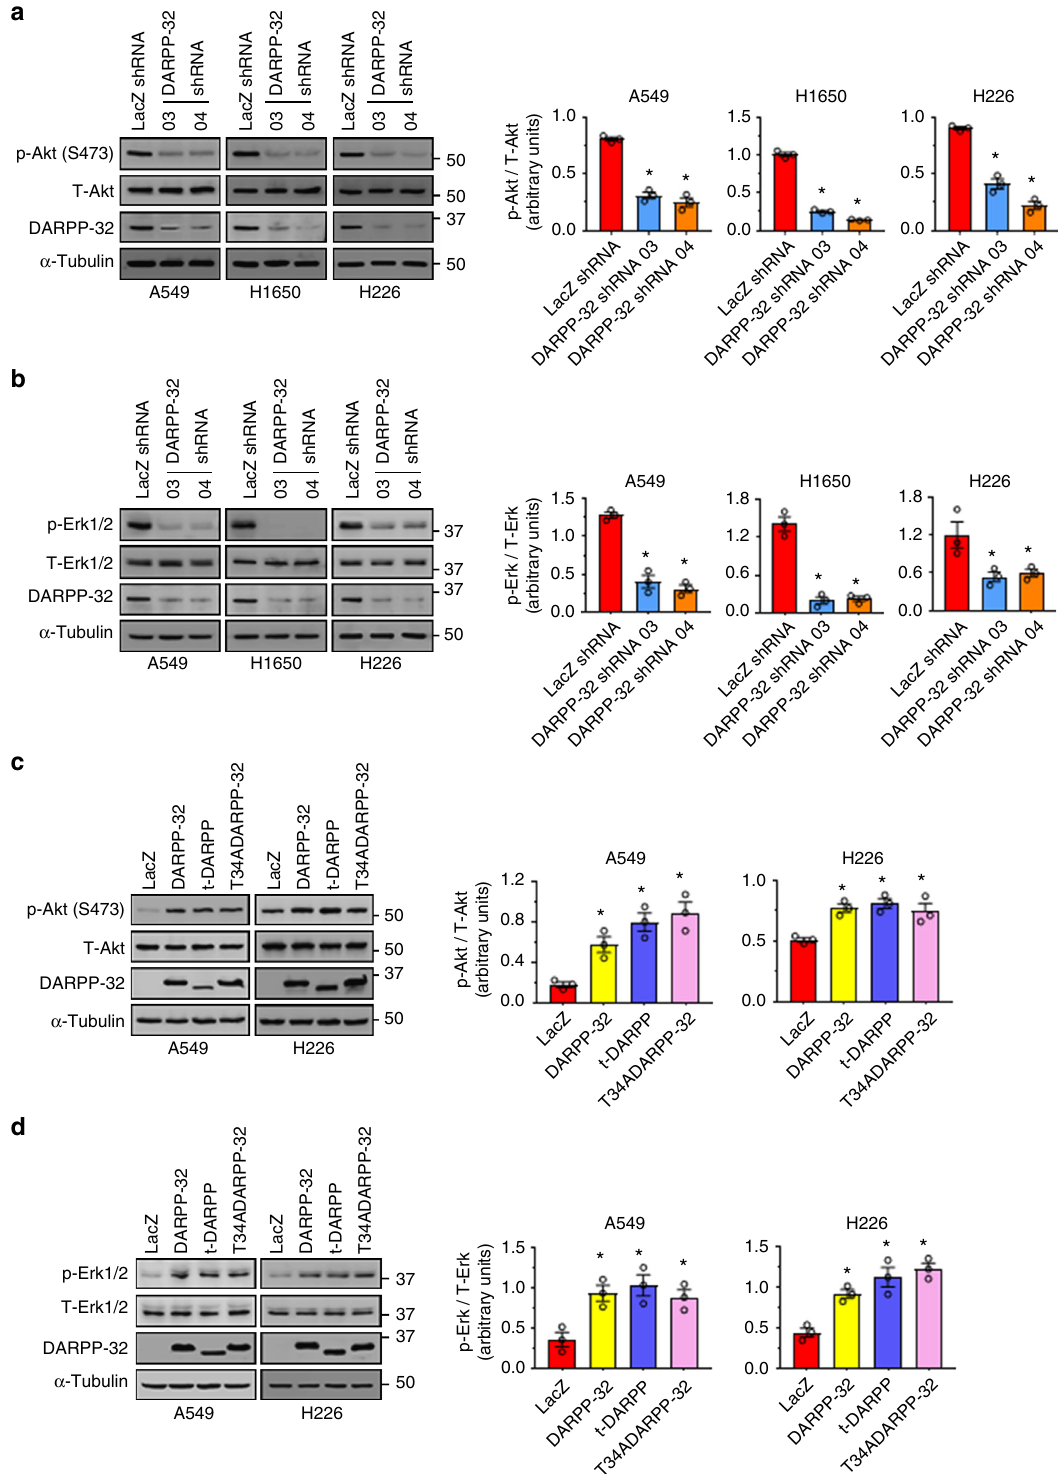
Fig. 2 DARPP-32 regulates cell survival through Akt and Erk1/2. a A549, H1650 and H226 cells were transduced with control or DARPP-32 shRNAs. Cell lysates were collected and immunoblotted with antibodies against phosphorylated Akt (p-Akt; S473), total Akt (T-Akt), b phosphorylated Erk1/2 (p-Erk1/ 2), total Erk1/2 (T-Erk1/2), DARPP-32 and α -tubulin (loading control). c A549 and H226 cells were transduced with control, DARPP-32-, t-DARPP- or T34A DARPP-32-overexpressing clones. Phosphorylated Akt (p-Akt; S473), total Akt (T-Akt), d phosphorylated Erk1/2 (p-Erk1/2), total Erk1/2 (T-Erk1/2), DARPP-32 and α -tubulin (loading control) proteins were detected by immunoblotting of cell lysates. Densitometry of the indicated immunoblots was performed using ImageJ software. Each open circle on a graph represents an independent experiment. All immunoblots are representative of three independent experiments. Uncropped images of depicted immunoblots are shown in Supplementary Figs. 16, 17. All bar graphs represent mean ± SEM ( n = 3). * P < 0.05, one-way ANOVA followed by Dunnett ’ s test for multiple